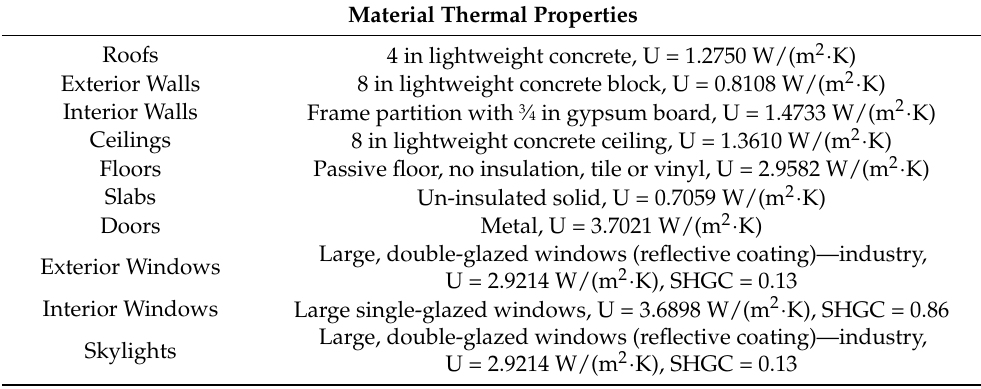
Table 4. Summary of material thermal properties.